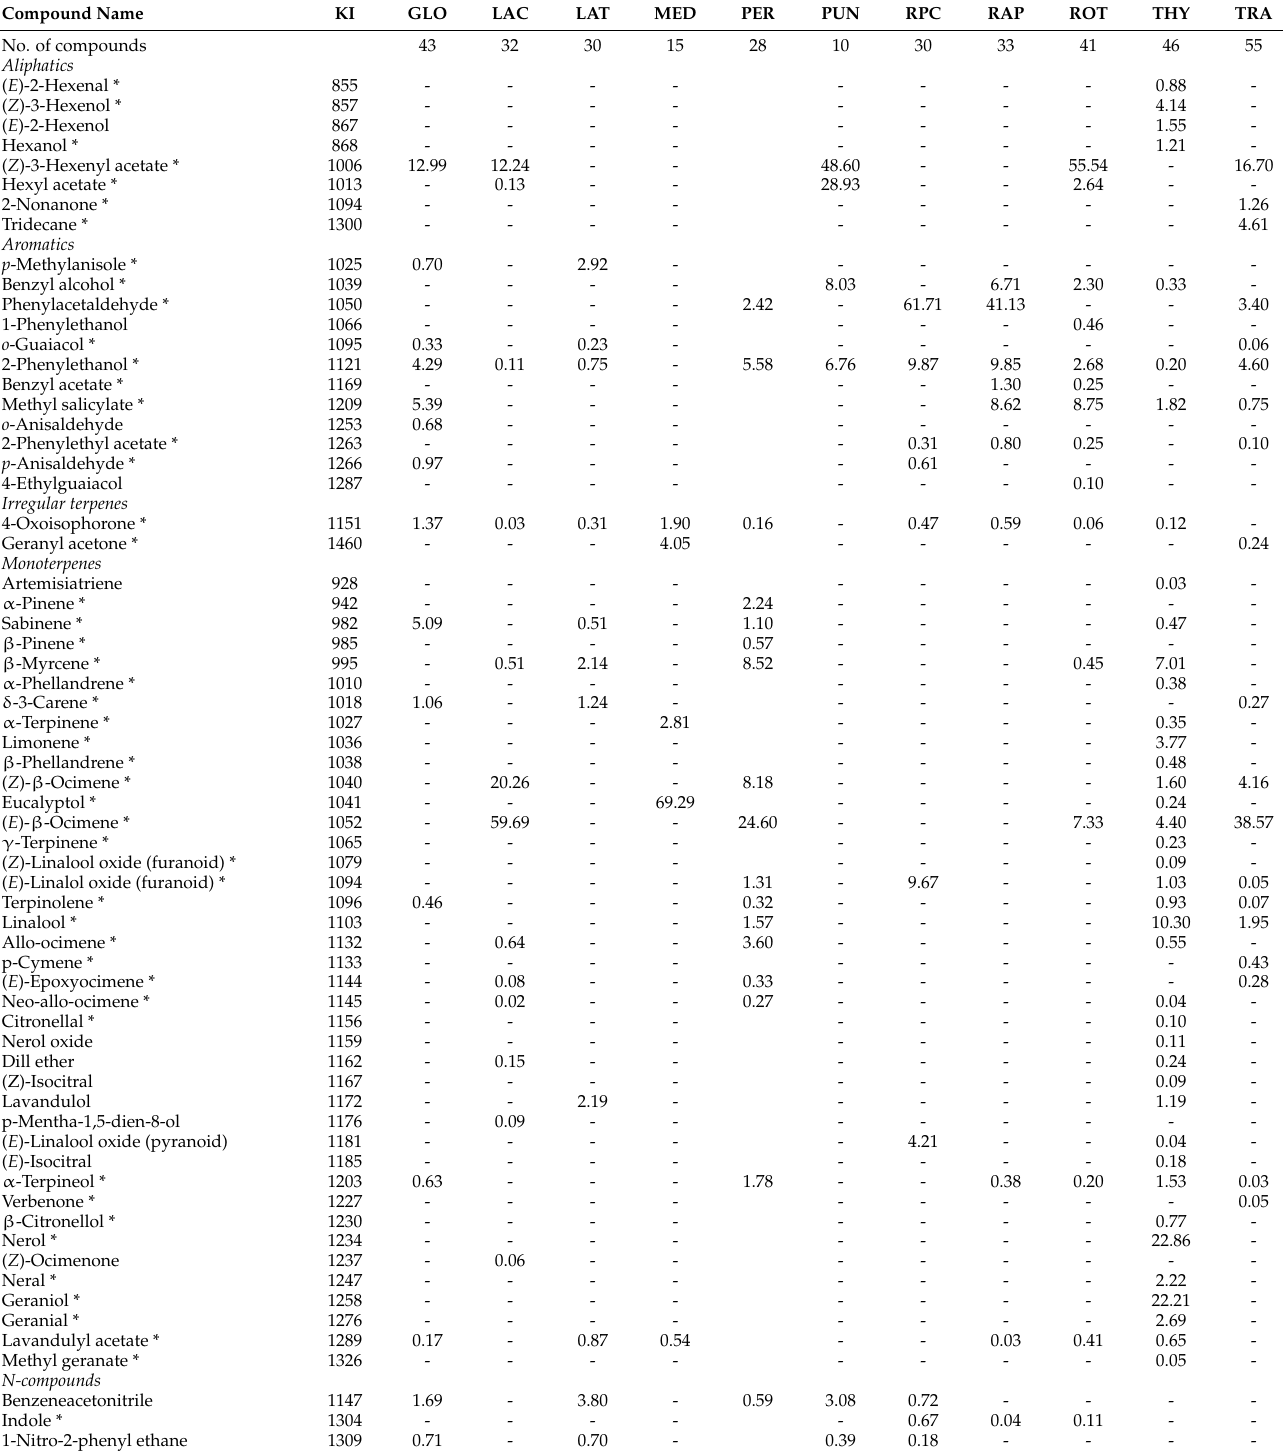
Table A1. Number and mean percentage amount of volatile compounds in scent samples collected from Campanula inflorescences of 11 species: Campanula glomerata (GLO), C. lactiflora (LAC), C. latifolia (LAT), C. medium (MED), C. persicifolia (PER), C. punctata (PUN), C. rapunculoides (RPC), C. rapunculus (RAP), C. rotundifolia (ROT), C. thyrsoides (THY), and C. trachelium (TRA). Volatiles are listed according to chemical class and Kovats Retention Indices (KI). The number